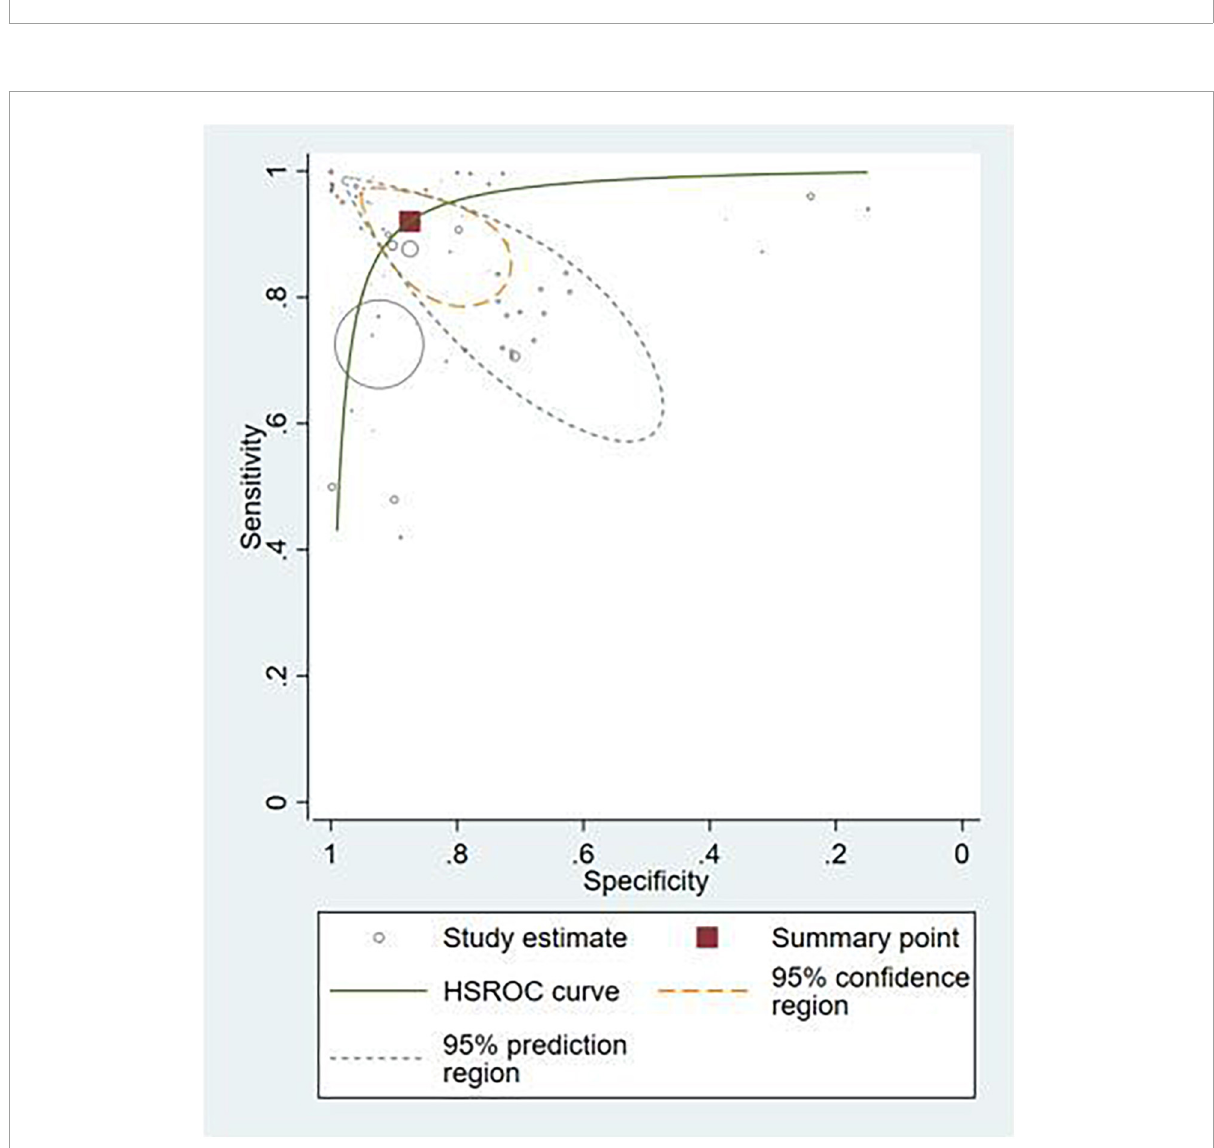
FIGURE4 Hierarchical summary ROC curve for externally validated